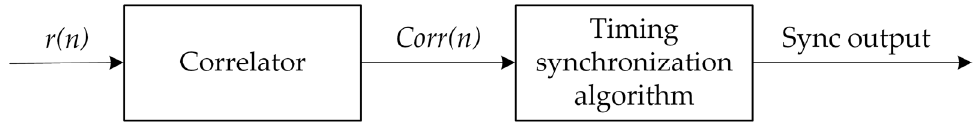
Figure 3. The proposed timing synchronization method.